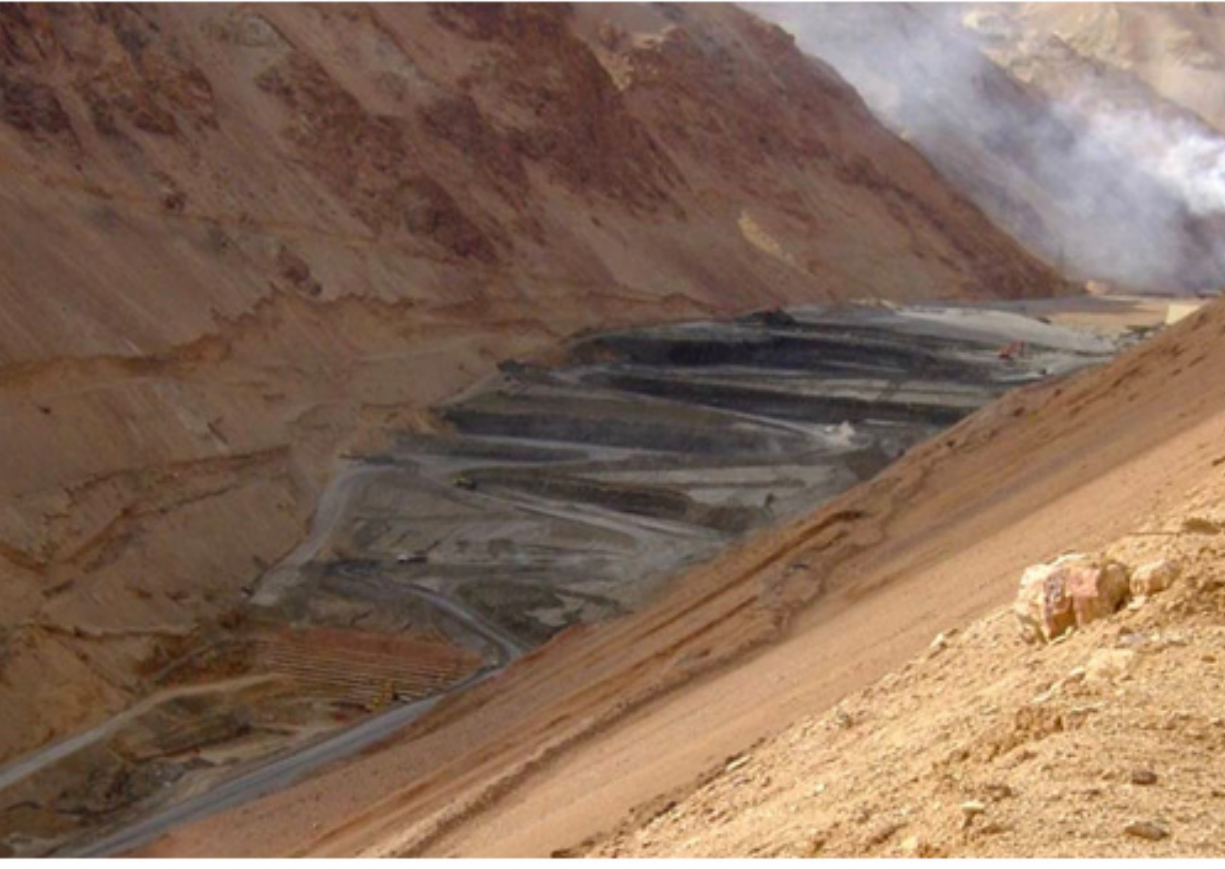
Figure 22. El Indio Filtered TSF Layout [53].